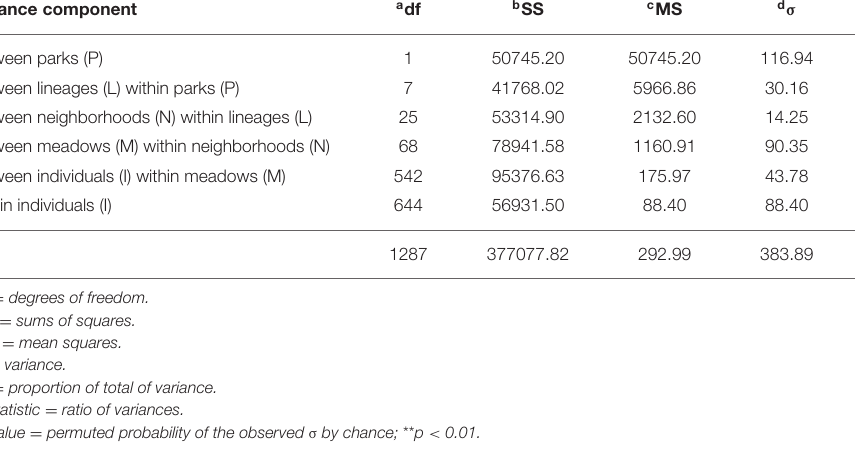
TABLE 2 | Analysis of Molecular Variance (AMOVA) results based on five hierarchical levels: park, lineage, meadow neighborhoods (defined by ADMIXTURE cross-validation), meadows, and individuals. Significance is based on 100 random permutations with one-tailed test. Variance